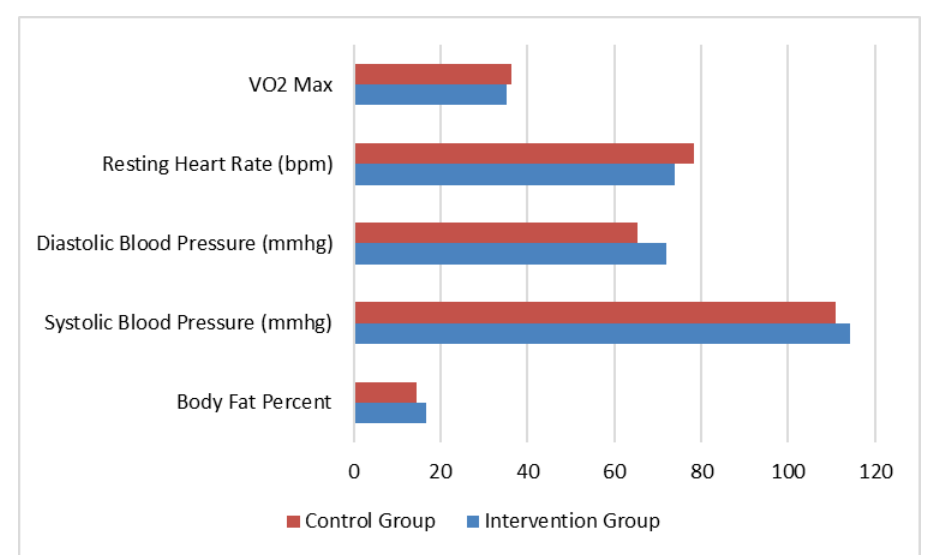
Figure 1. Mean Scores after 12 weeks of